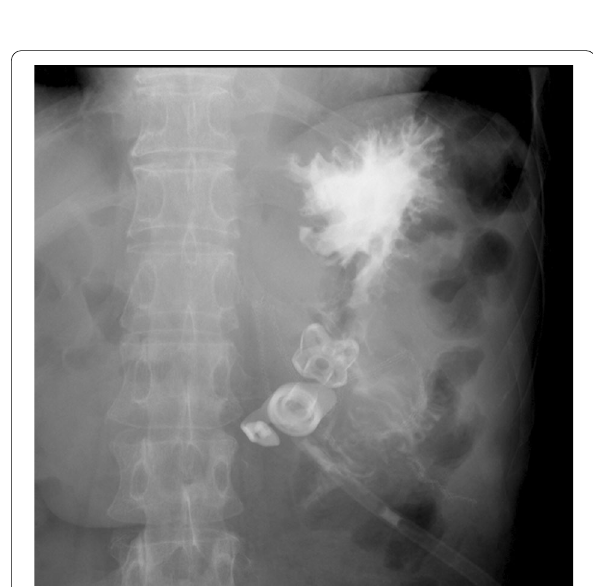
Fig. 5 Contrast radiography findings. There was no evidence of postoperative leakage or